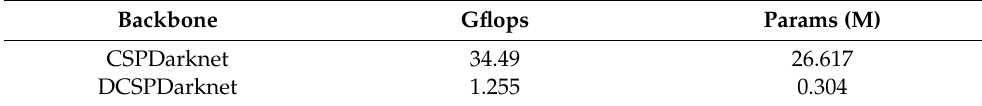
Table 1. Comparison of backbone network